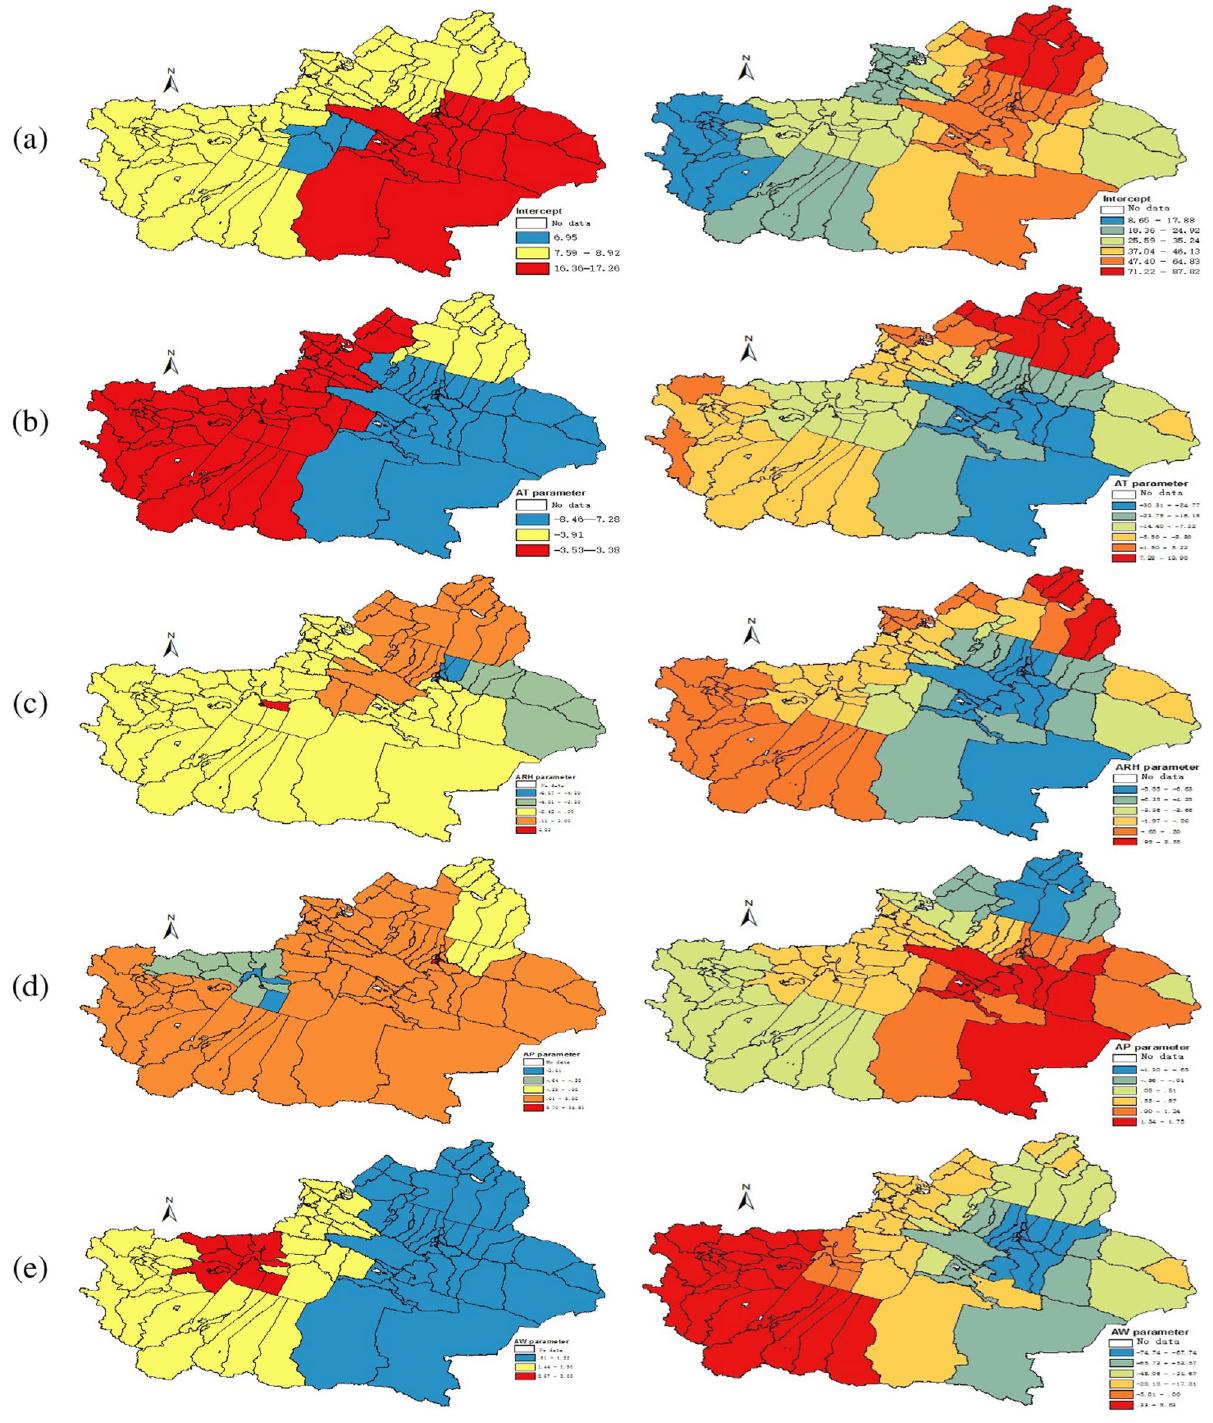
Figure 4. Spatial variation surface of SCC (left panel) and GWR (right panel) model estimation parameters in June 2018, and the estimated regression coefficients of Intercept, AT, ARH, AP, AW in rows ( a – e ),